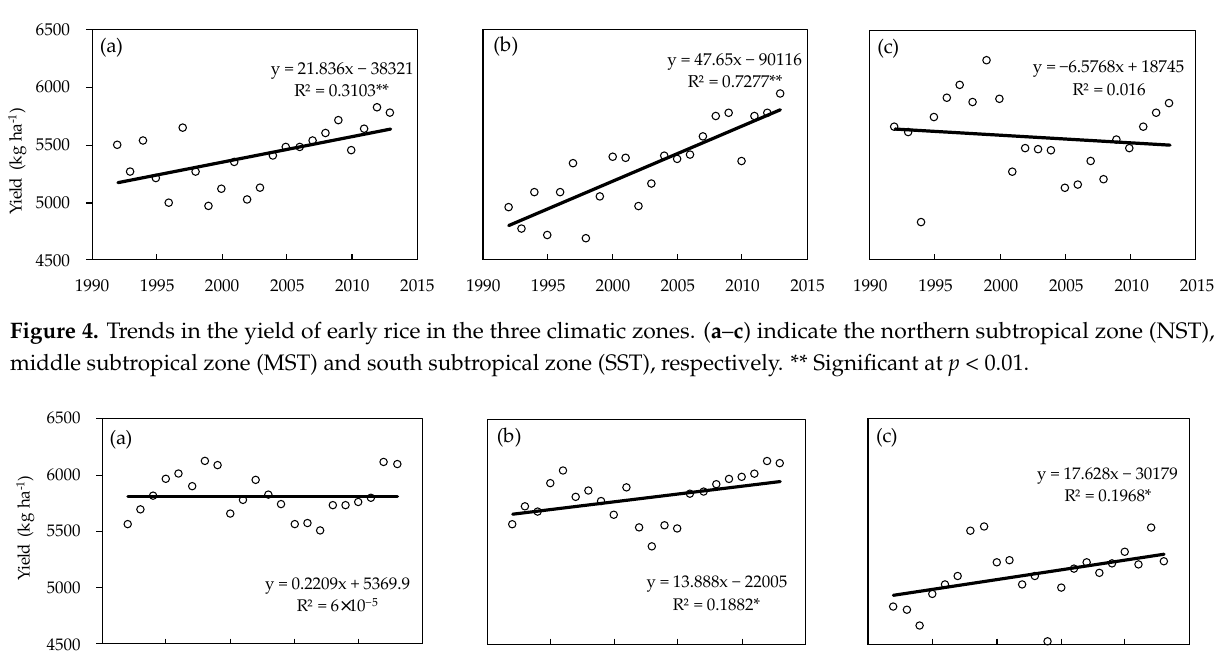
Figure 3. Trends in average temperature ( a – c ) and solar radiation ( d – f ) of the late rice growth period in the three climatic zones. ( a , d ), ( b , e ), and ( c , f ) indicate the northern subtropical zone (NST), middle subtropical zone (MST) and south subtropical zone (SST), respectively. ** Significant at p < 0.01.